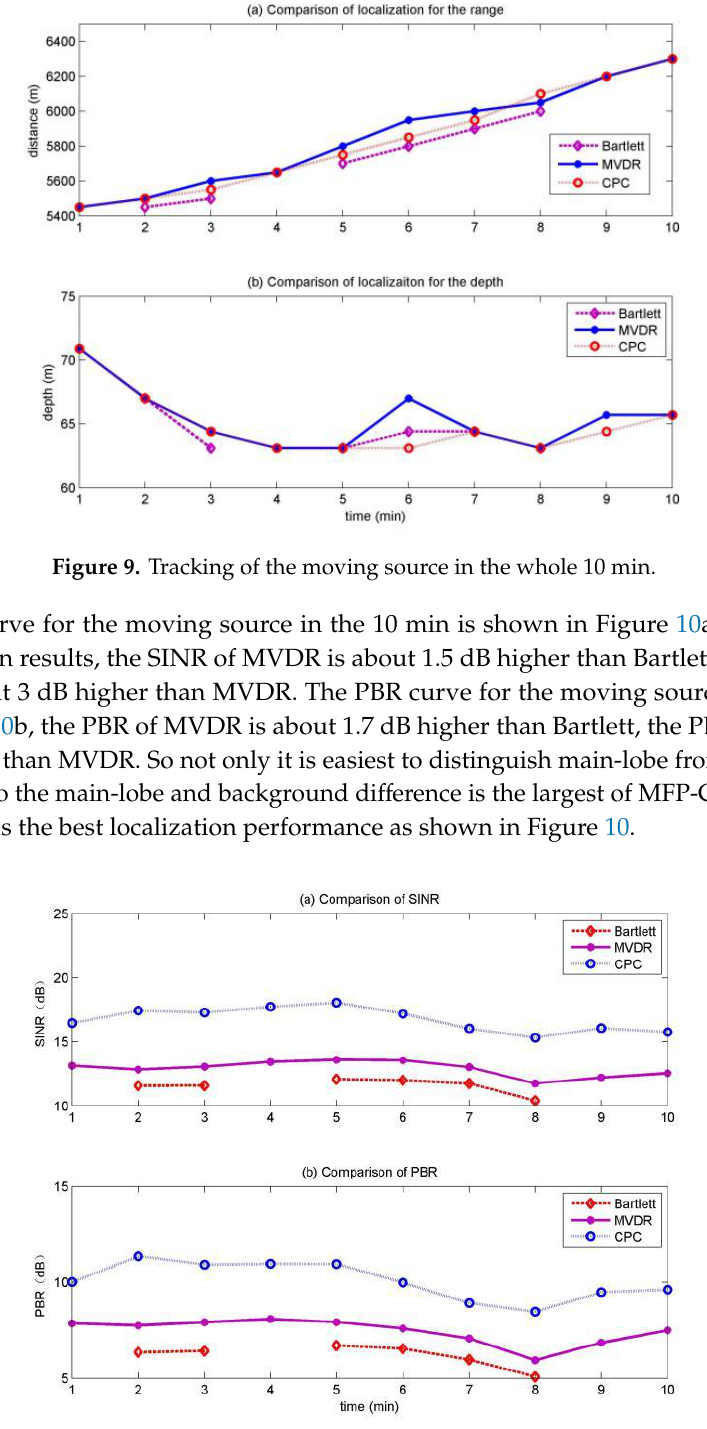
Figure 10. Localization performance for the moving source.